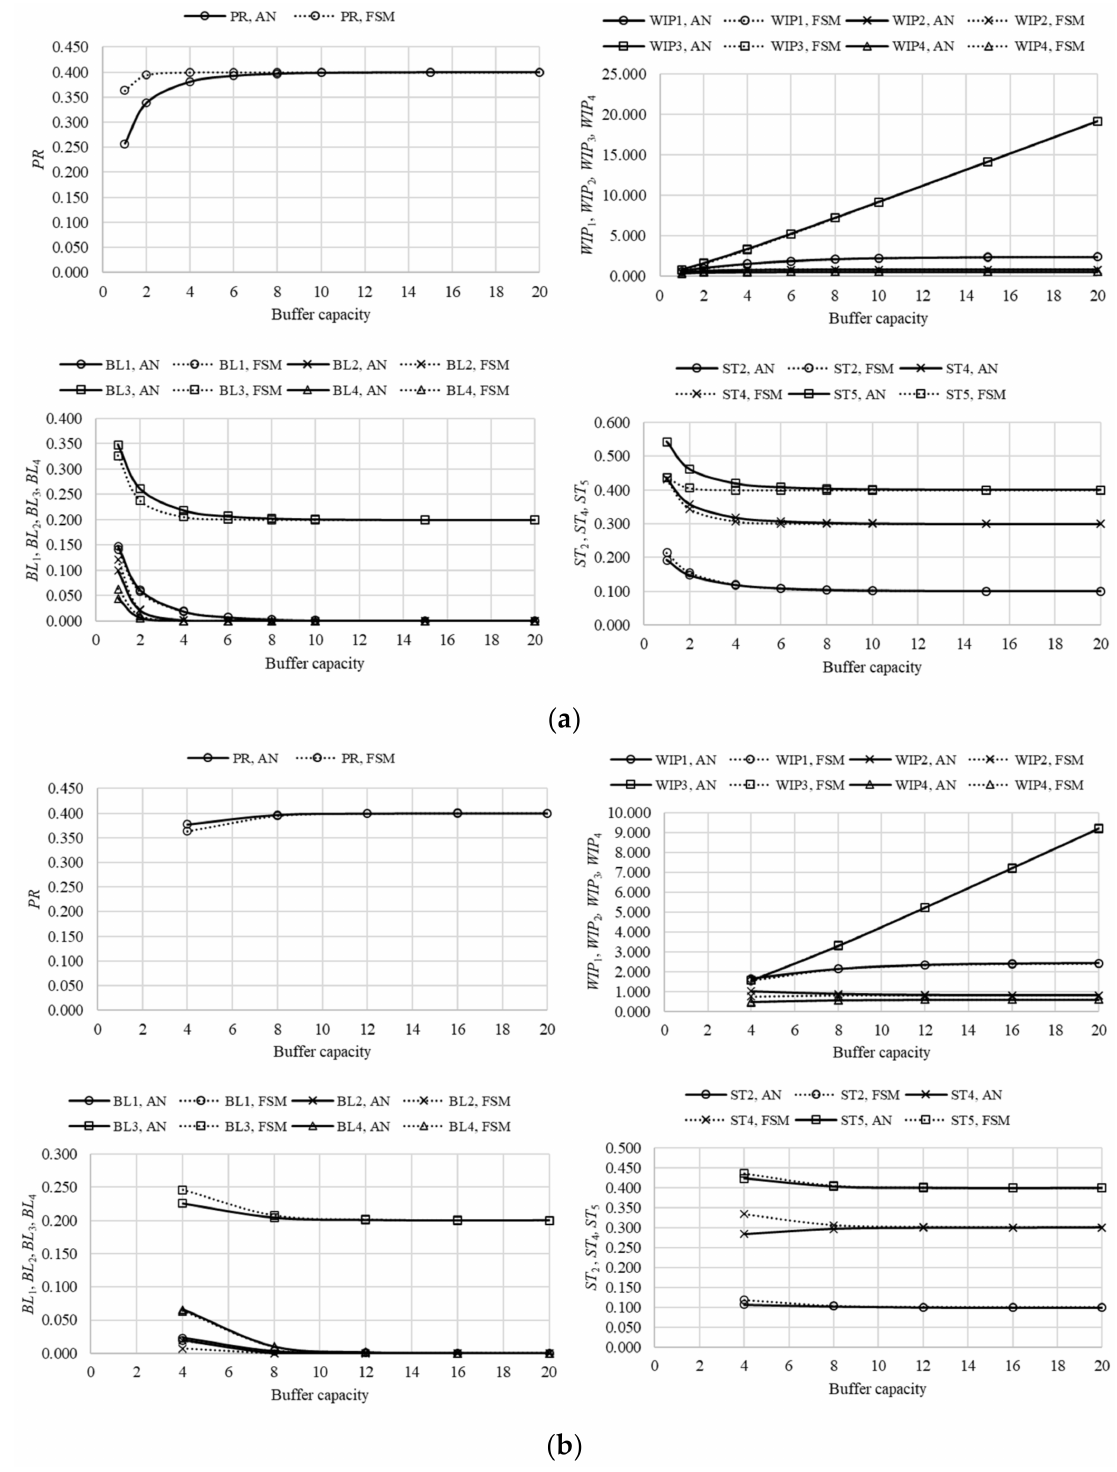
Figure 11. Comparison of the performance measures in the case of line L5C: ( a ) N 1 = N 2 = N 3 = N 4 = N ; ( b ) N 1 = N , N 2 = 3 / 4 N , N 3 = 1 / 2 N , N 4 = 1 / 4 N